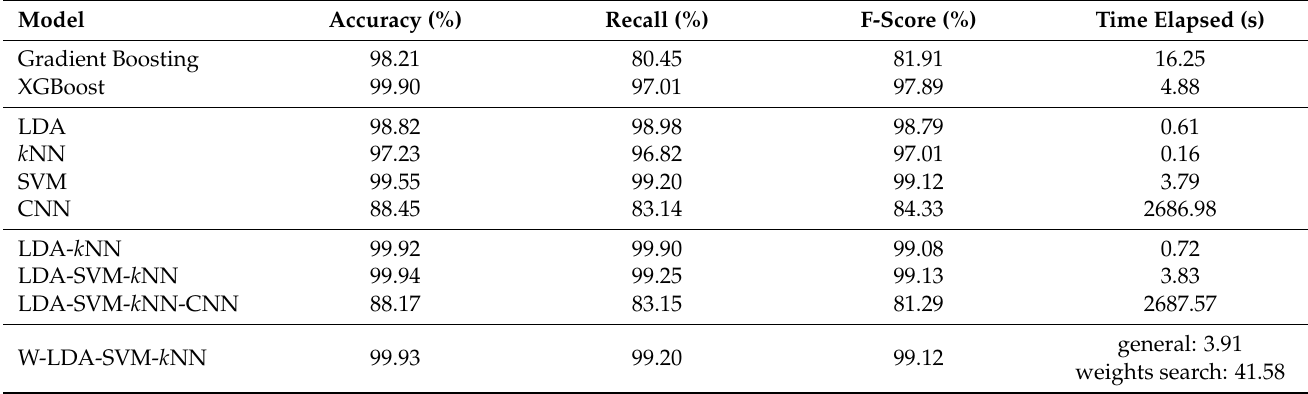
Table 2. Test results using 8-channel data of healthy